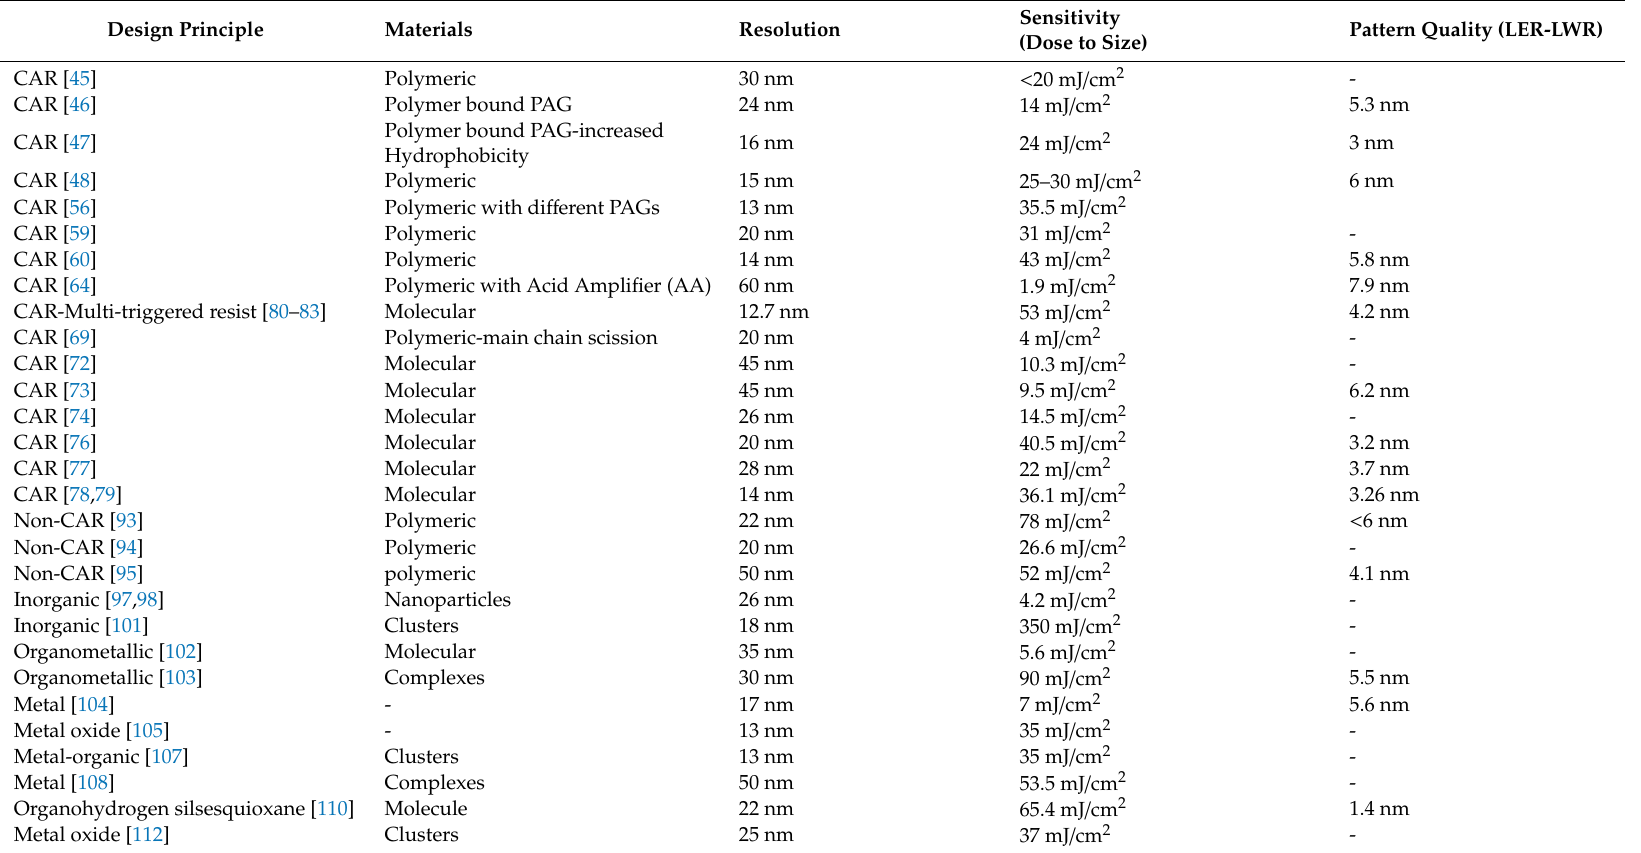
Table 1. Performance characteristics (see text) of the most promising resists materials reviewed based on di ff erent design